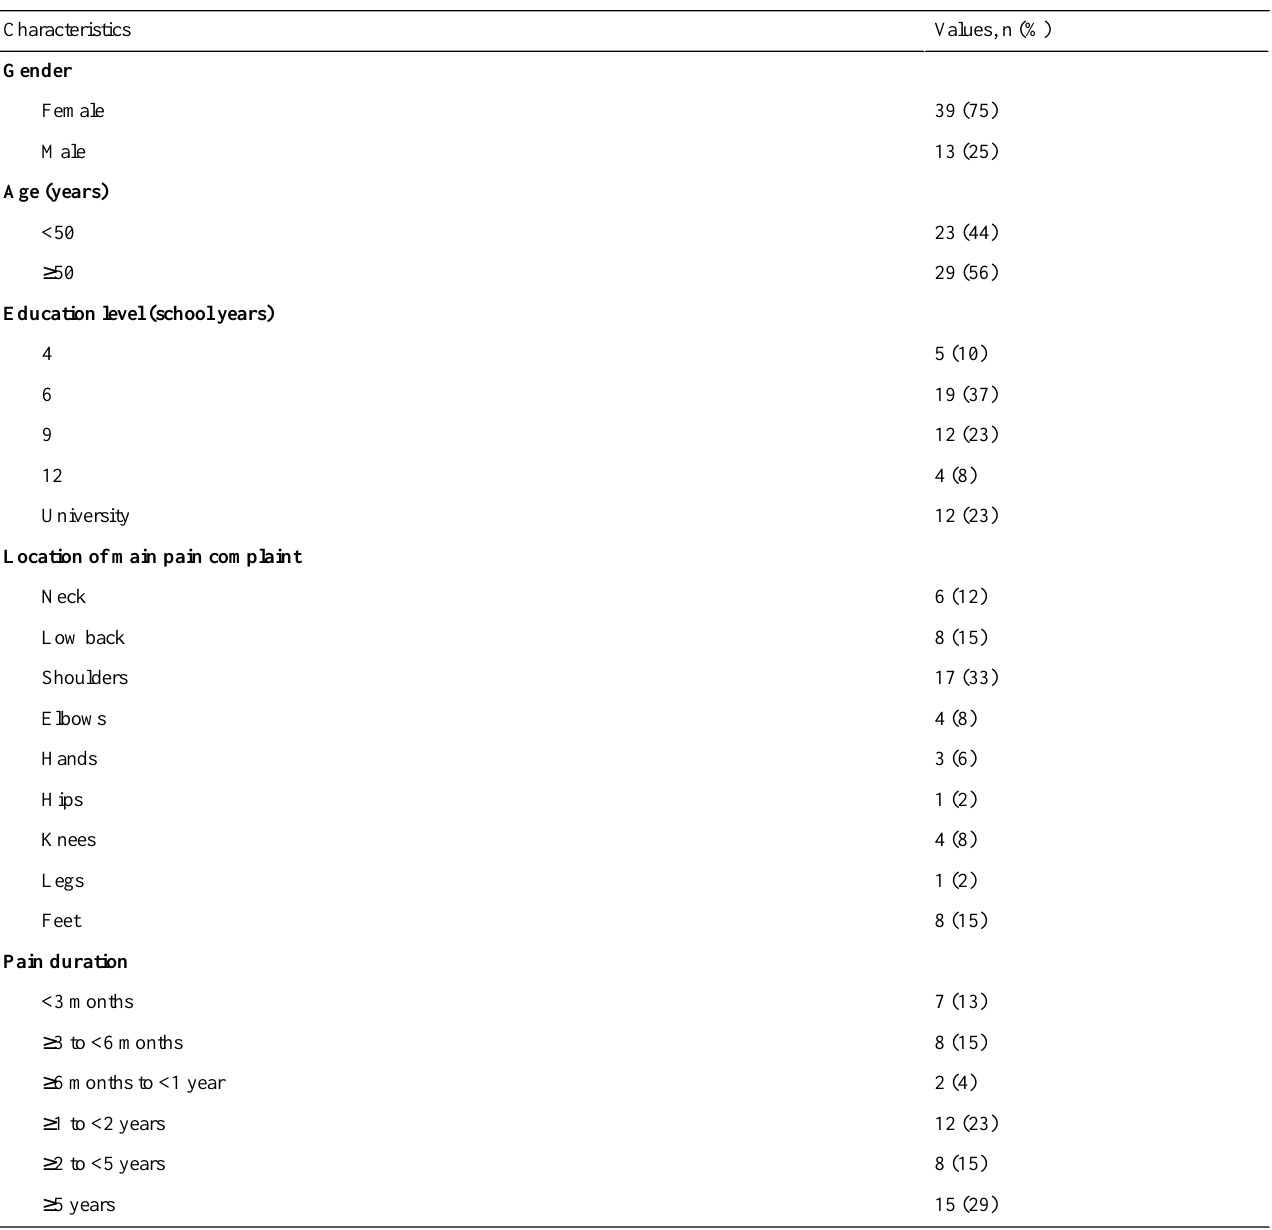
Table 5. Characteristics of patients who participated in the assessment of the final version of the app